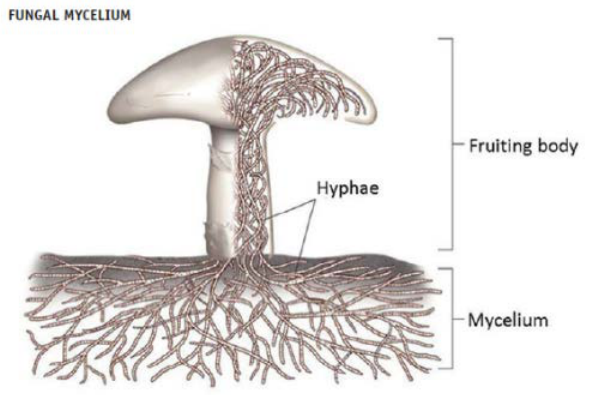
Figure 1 Fungal Composition Divided into Underground Mycelium and Fruiting Body (Url-1).